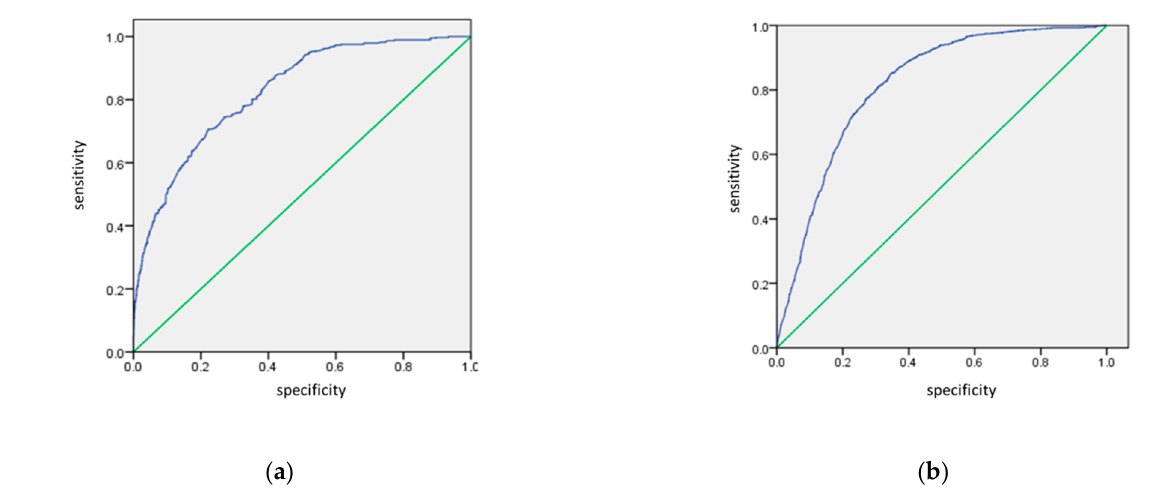
Figure 3. ROC test values of ( a ) emerging industry land and ( b ) industrial land. Table 5. Comparison of the factors influencing land use change in emerging industry and traditional industry in Shenzhen.